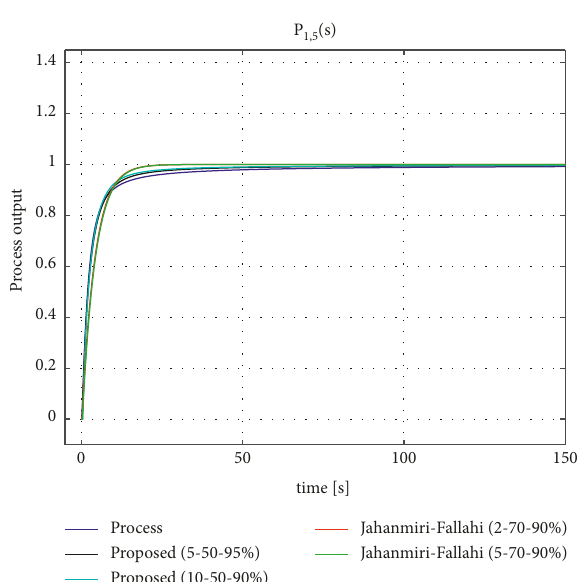
Figure 11: Process reaction curve and step responses for FFOPDT model methods # 1 and # 2 and SOPDT methods # 12 and # 13, respectively.